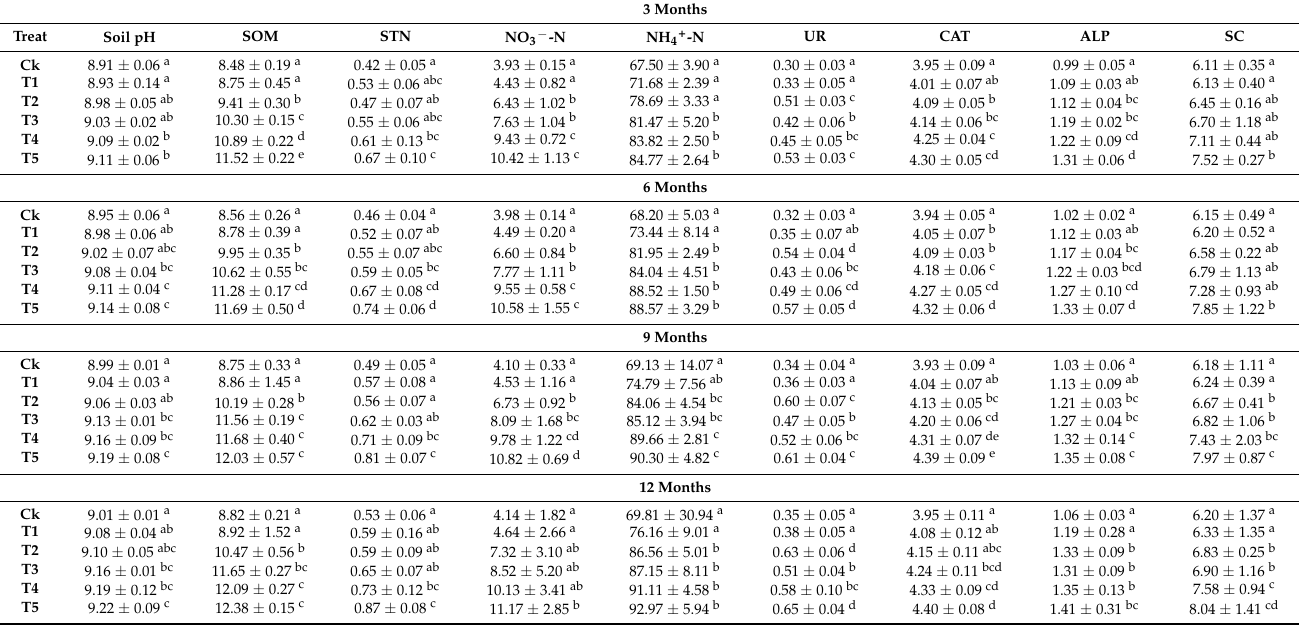
Table 3. Impact of biochar application on soil physiochemical properties and enzymatic activities across the months.